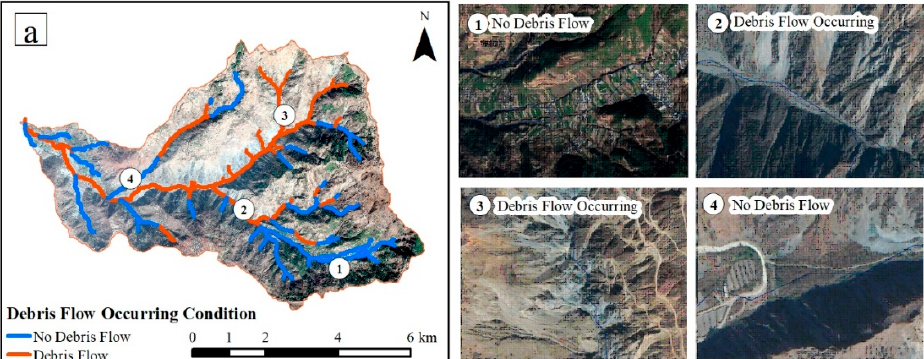
Figure 9. Identification of debris flow occurring in the gullies: ( a ) Identification results of debris flows; ① – ④ Local enlargement pictures of high-resolution remote sensing images. The blue lines in the pictures are the gully lines.